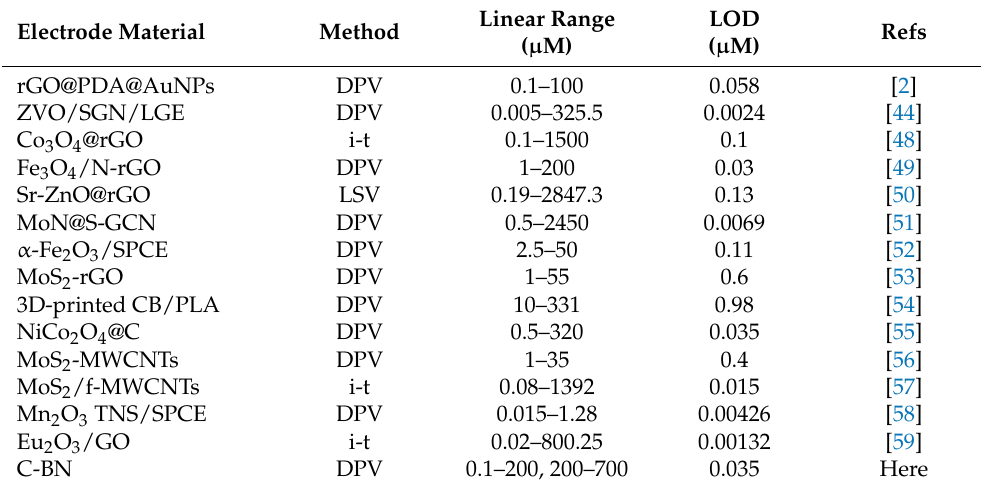
Figure 8. ( a ) DPV responses of C-BN/GCE toward different CAP concentrations; ( b ) corresponding linear plots of I pc vs. CAP concentration (Circle dots are experimental data and red lines are fitting results). (Conditions: 0.2 M PBS with pH of 7.0, scanning window: − 0.8– − 0.4 V, modulation amplitude: 50 mV, potential increment: 4 mV, pulse width: 0.05 s). Table 1. Comparison of the analytical performance of C-BN/GCE with previously reported electro- chemical methods for CAP